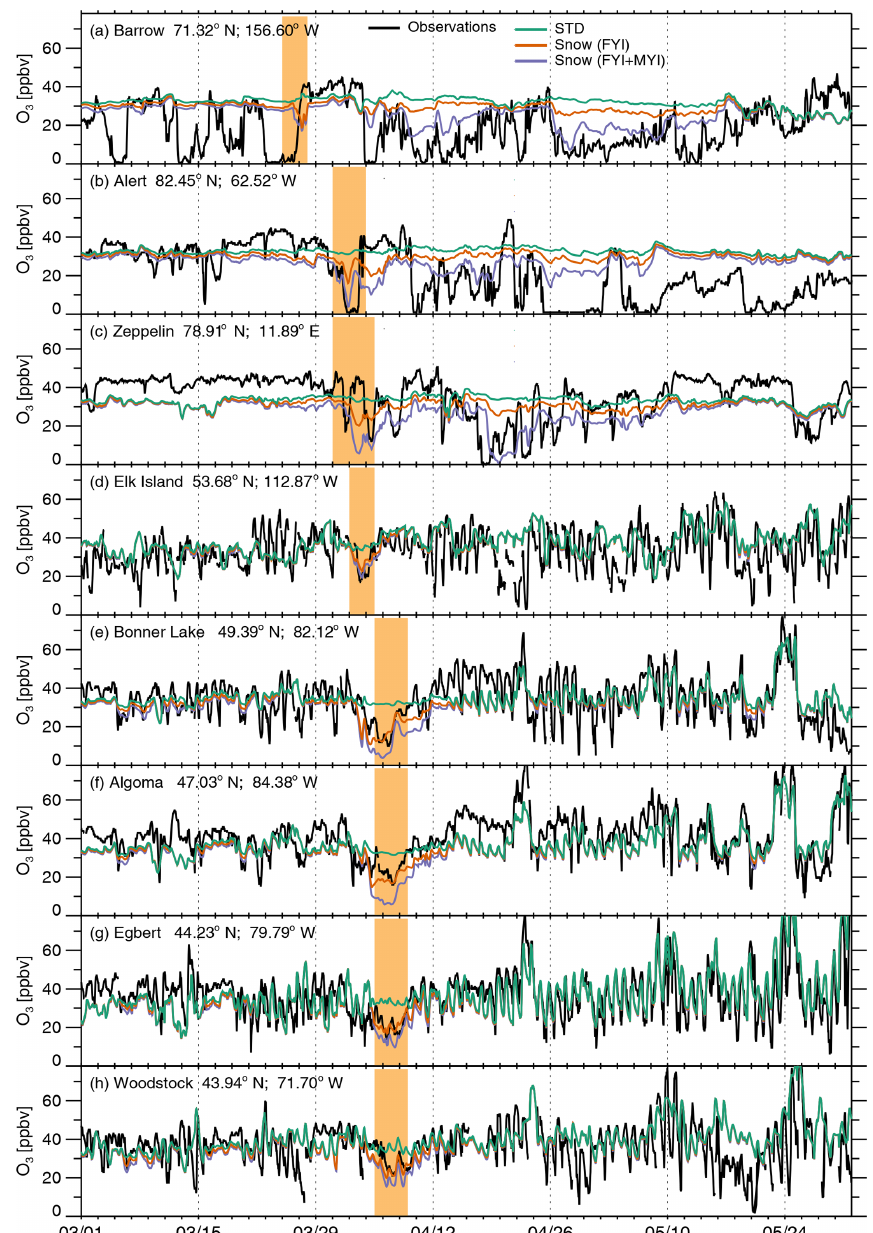
Figure 8. Time series of hourly surface O 3 (ppbv) at three Arctic sites (a–c) and five sub-Arctic sites (d–h) for 1 March–31 May 2007 (in the date format of month/day): (a) Utqia˙gvik (Barrow), Alaska, USA; (b) Alert, Nunavut, Canada; (c) Zeppelin, Spitsbergen, Norway; (d) Elk Island, Alberta, Canada; (e) Bonner Lake, Ontario, Canada; (f) Algoma, Ontario, Canada; (g) Egbert, Ontario, Canada; and (h) Woodstock, New Hampshire, USA. In situ observations are shown with the black lines, while the GEOS-Chem STD, FYI Snow, and FYI+MYI Snow simulations are shown in green, orange, and purple, respectively. The shaded orange area corresponding to the times when the large BrO hotspot from 26 March to 4 April 2007 is predicted to be observed at the three Arctic sites and then transported to the sub-Arctic